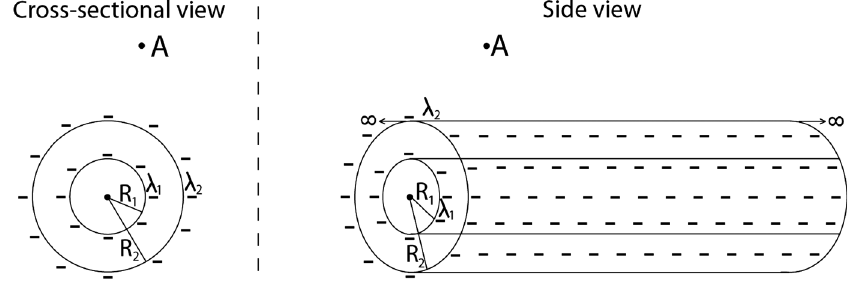
FIG. 8. A schematic diagram for the post-test questions (2) and